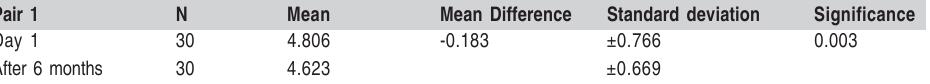
Table 4. A comparative analysis of masticatory efficiency on the day of denture fit and